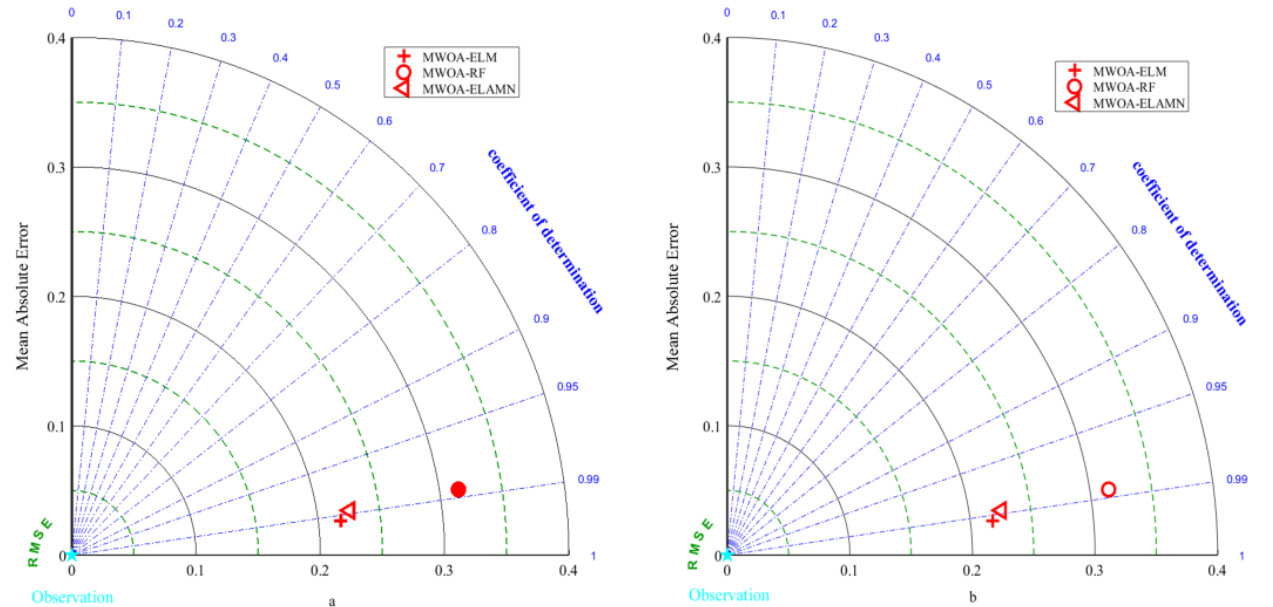
Figure 12. Taylor diagrams for the Training ( a ) and Testing ( b ) sets of the MWOA-ELM, MWOA-RF and MWOA-ELMAN models Table 8. Average of evaluation indicators for MWOA-ELM,MWOA-RF, and MWOA-ELMAN